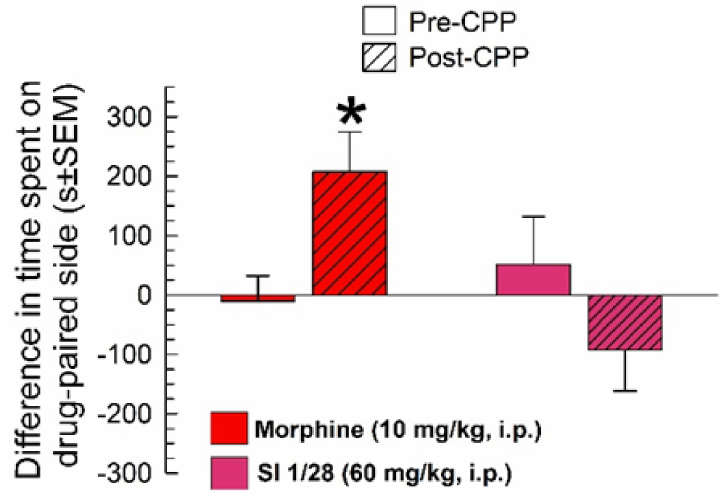
Figure 4. SI 1/28 (60 mg/kg/d, i.p.; n = 20) did not demonstrate place conditioning preference or aversion, whereas morphine (10 mg/kg, i.p.) showed significant conditioned place preference ( n = 22) in the mouse conditioned place preference assay. * = post-conditioning response (striped bars) significantly different from matching pre-CPP response (matching open bars), p = 0.003; two-way RM ANOVA w/Sidak’s post hoc test.